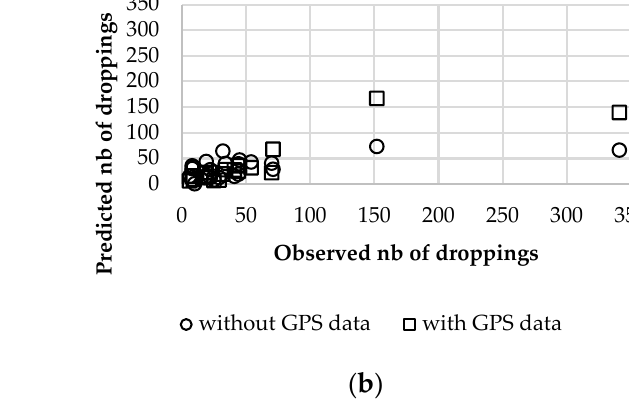
Figure 15. Relationship between observed and predicted number of droppings for the best model in Table 2 and for the equivalent model excluding GPS data. ( a ) Calibration data set. ( b ) Validation data set.